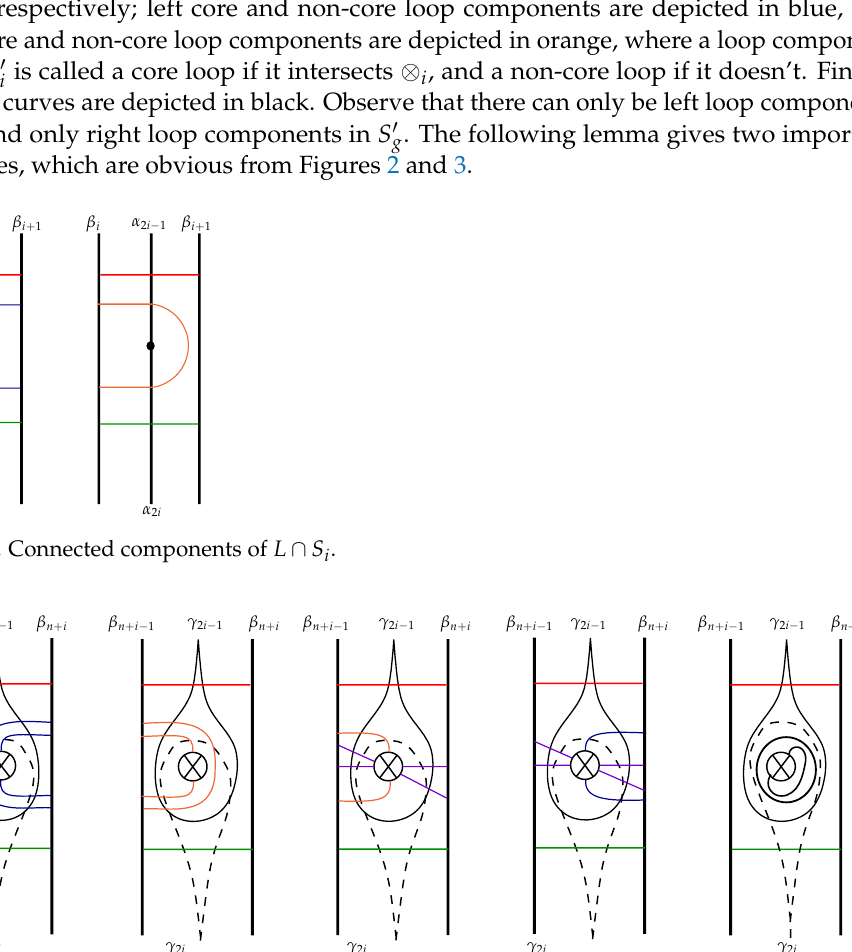
S 0 i Figure 3. Connected components of L ∩ S (cid:48) i ∩